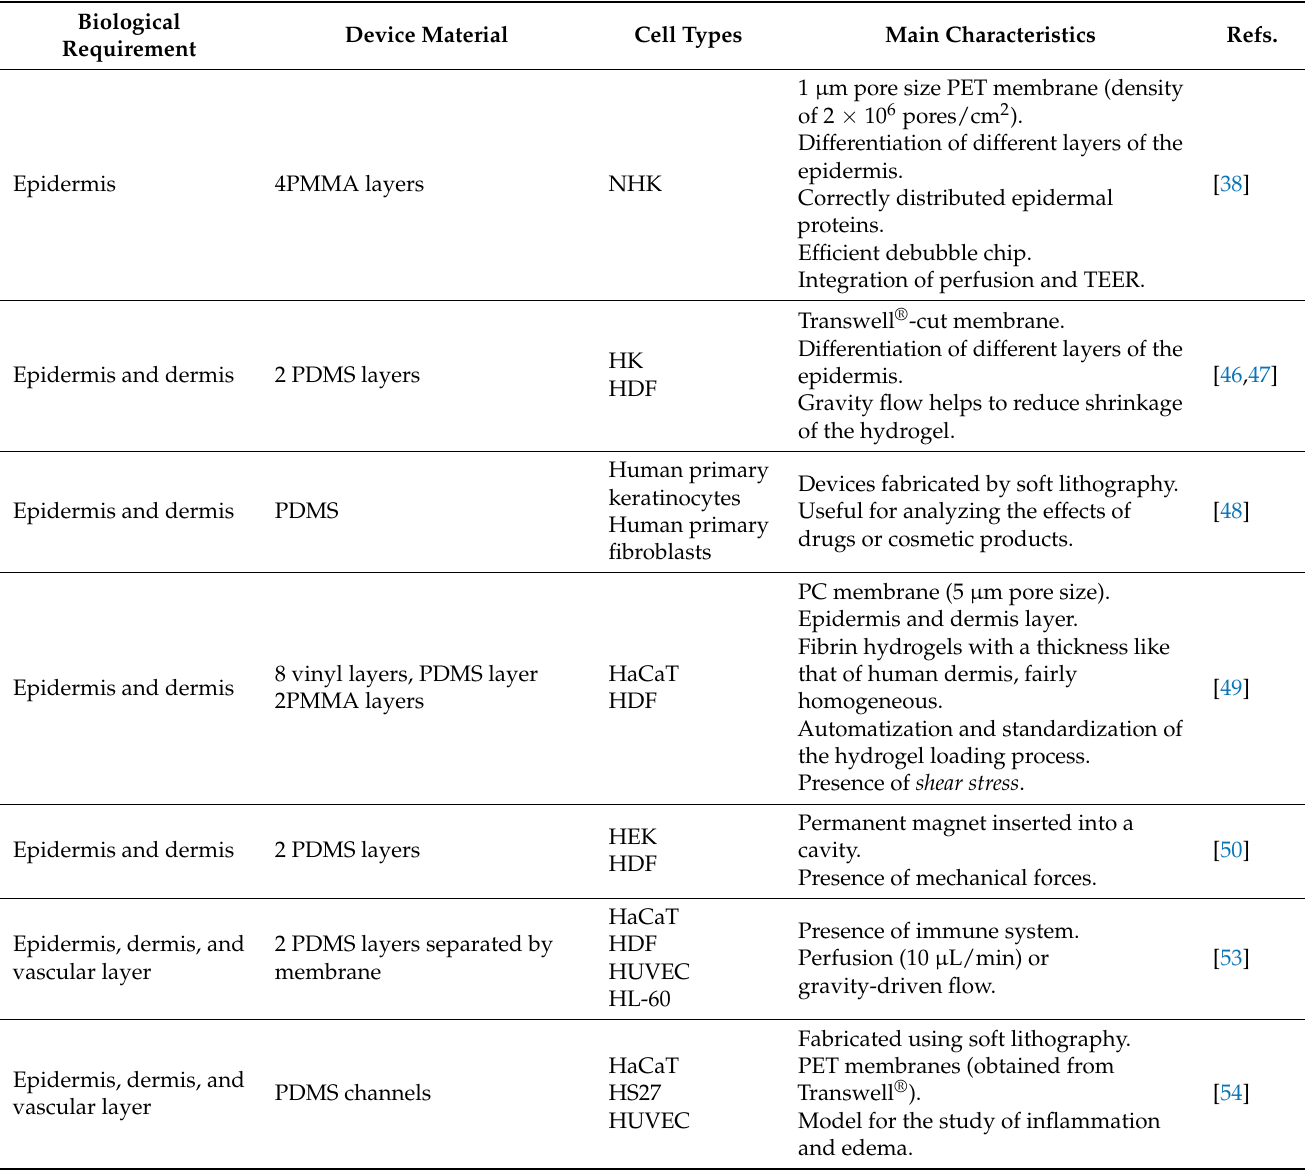
Table 2. Human SoCs reported with different biological